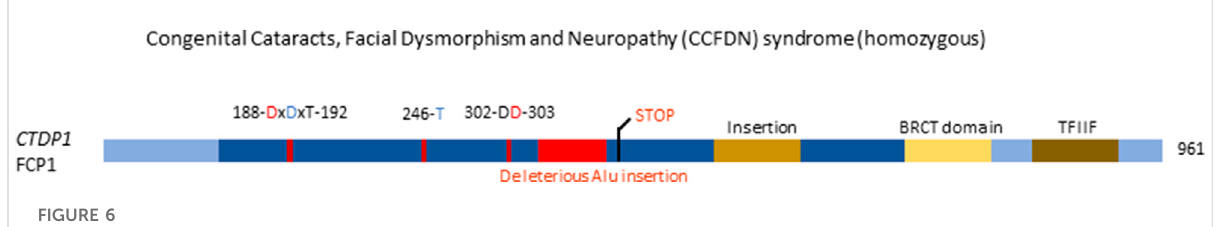
FIGURE 6 Congenital disease-causing variants in the HAD Ser/Thr phosphatases. Variants in the HAD phosphatase FCP1, encoded by CTDP1 . Domains and conserved amino acids are indicated. Red amino acids denote metal binding, blue denote phosphate binding. Variants in red denote alleged or proven loss-of-function mutant. Dotted lines near variants denote that functional or molecular data have been